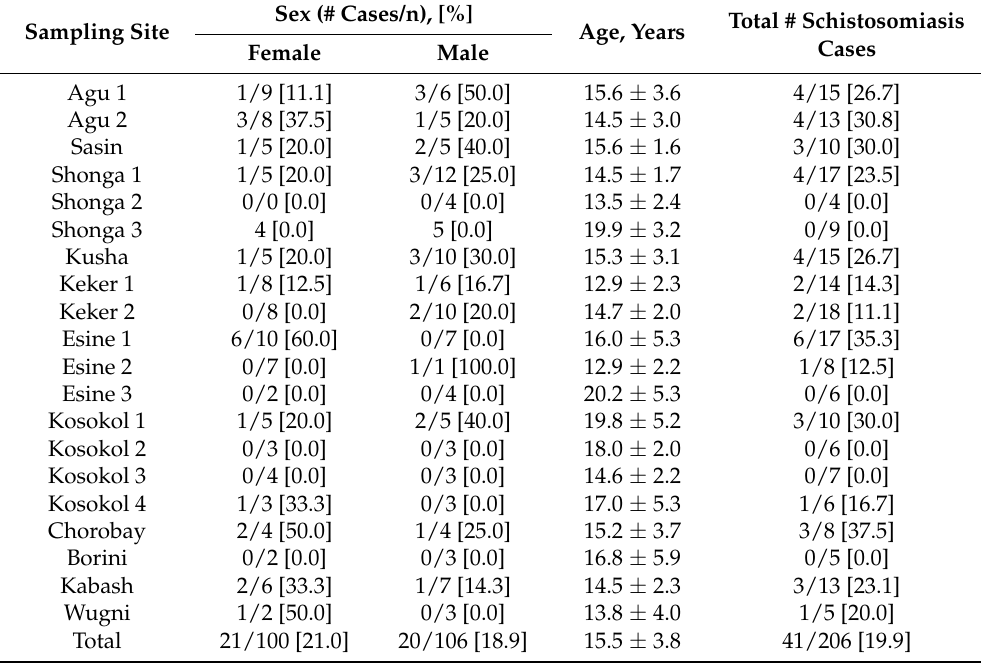
Table 3. Characteristics of the study population across the sampling sites n = 206. Sampling